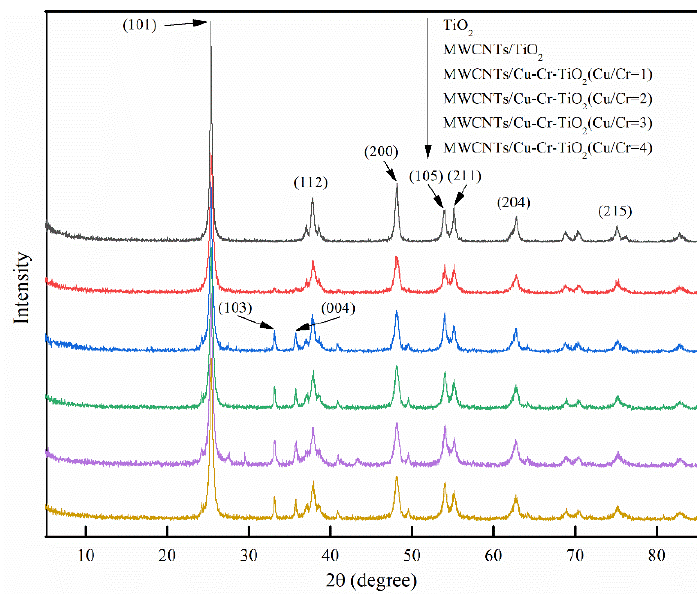
Figure 4. X-ray diffraction (XRD) patterns of samples.